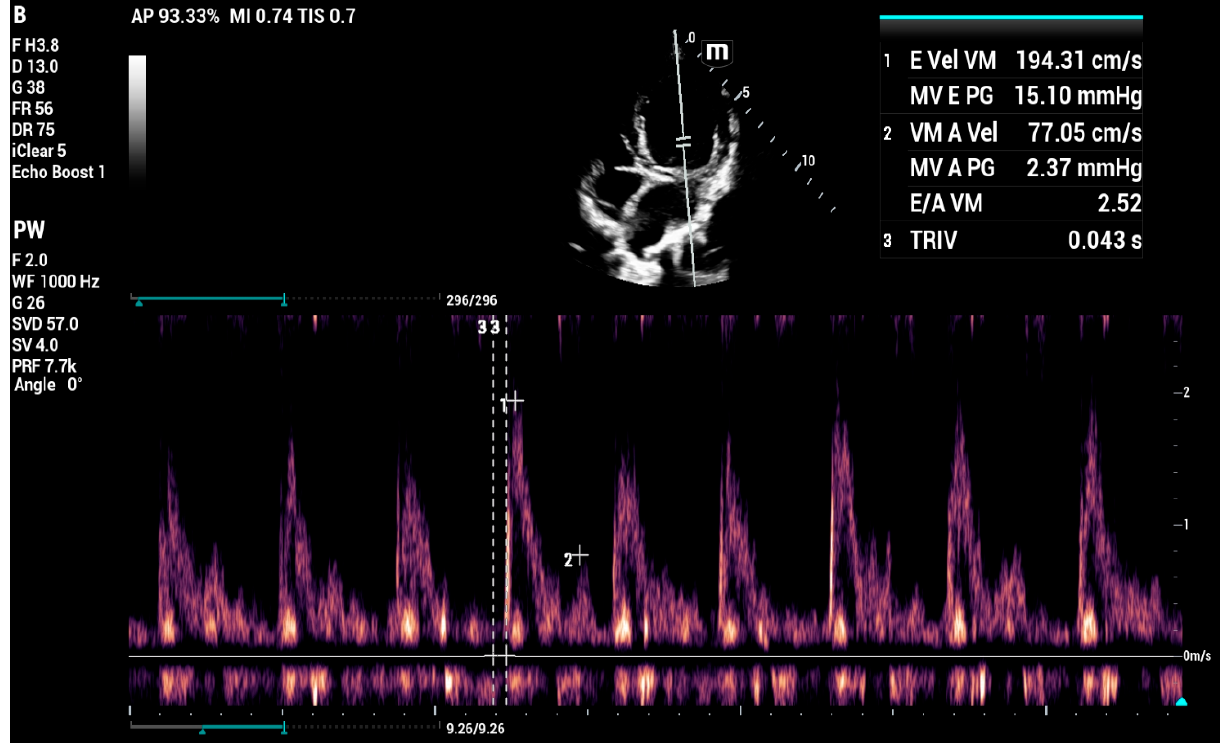
Figure 11. Increased E/IVRT ratio in a canine patient showing a restrictive pattern with mitral valve insu ffi ciency and cardiogenic pulmonary edema.